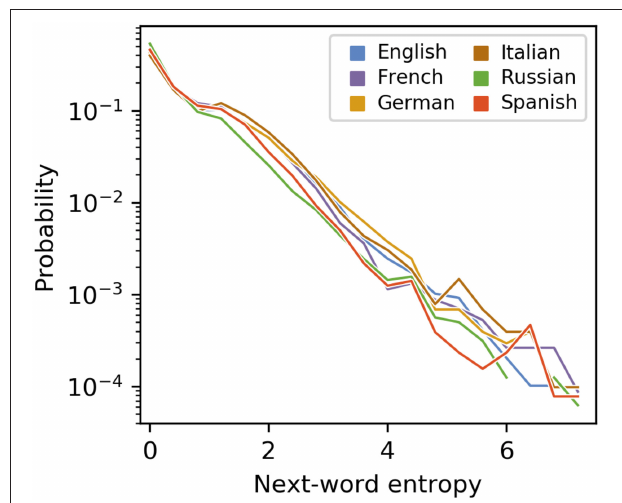
FIGURE 6 | Next-word entropy for different languages and null model. The next-word entropy is calculated for each word using Equation (15). The plotted values are the normalized frequencies (i.e., probabilities) of words whose next-word entropy falls within each bin; the first bin contains values greater than or equal to 0 and less than 1 / 2, the second contains values greater than or equal to 1 / 2 and less than 1, and so on.